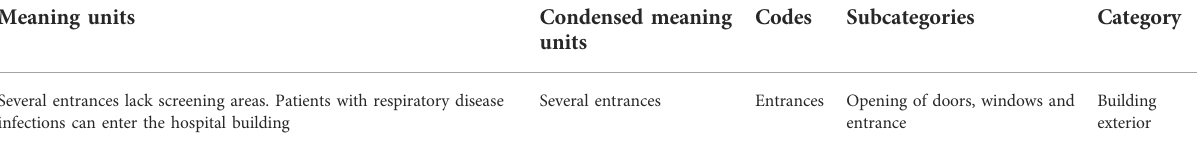
TABLE 2 Example of the interviews content analysis used in this